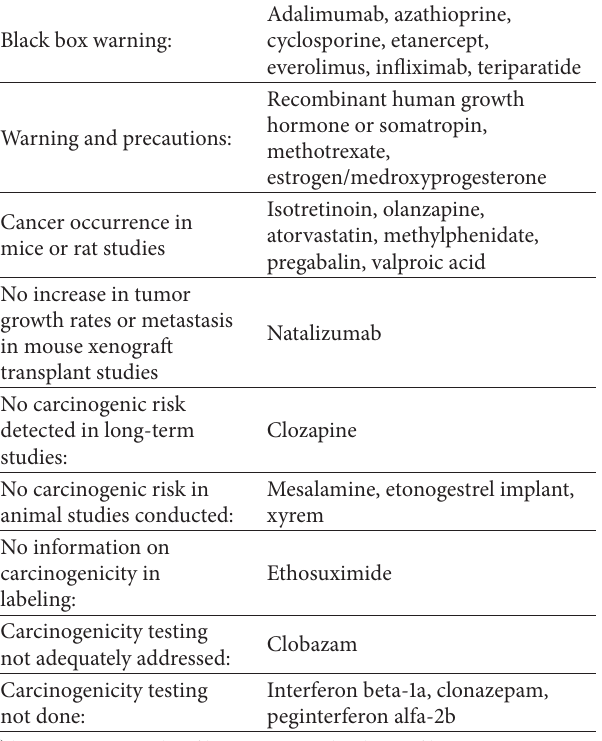
Table 3: Product labeling information on carcinogenicity for med- ications reported in FAERS that were used pre-ESFT diagnosis (Drugs@fda) ∗